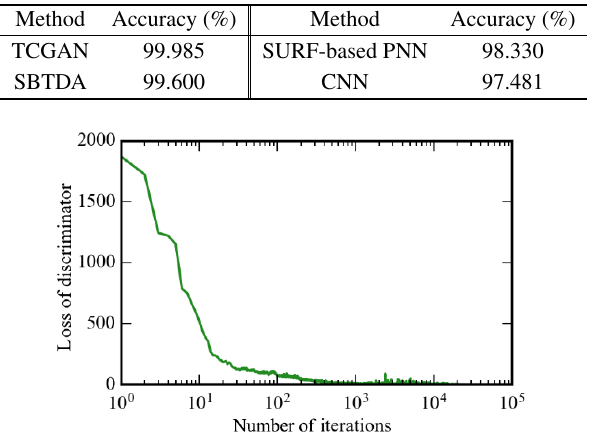
Fig. 11 Loss of discriminator with 2000 samples in Case 2.